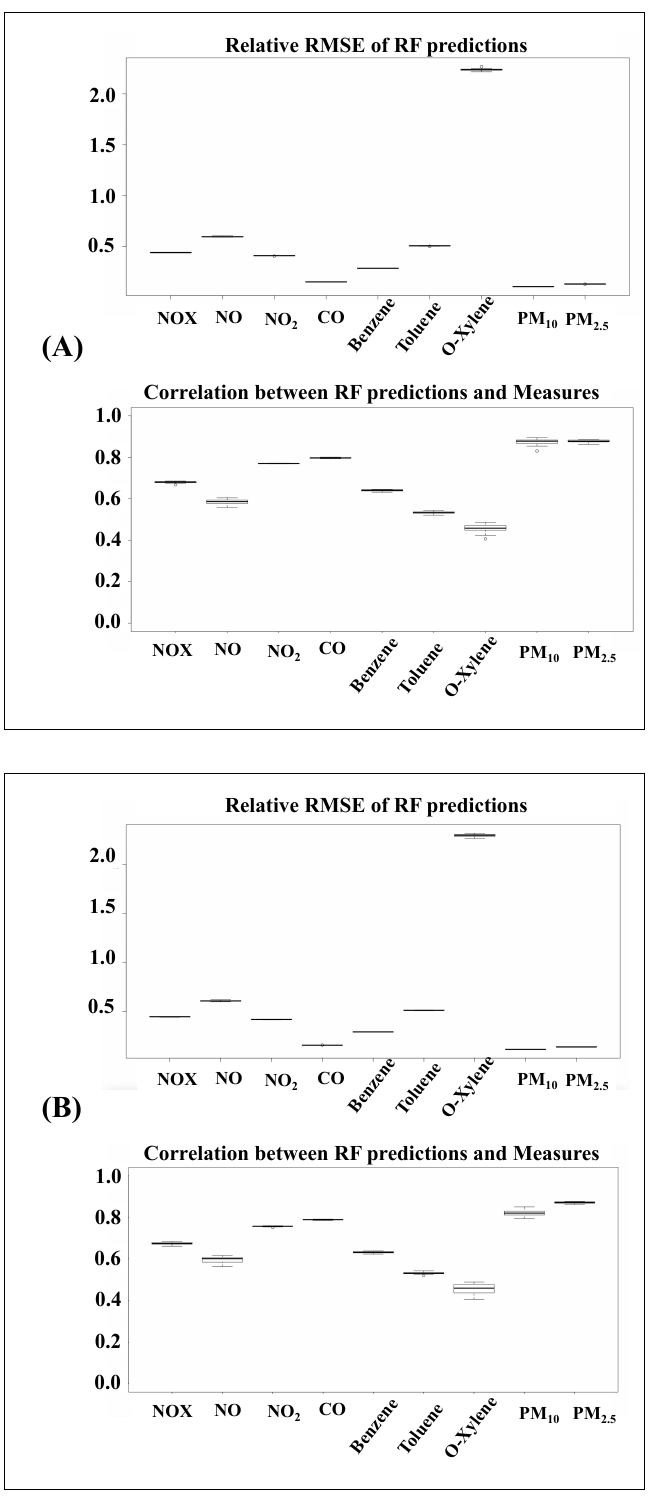
Figure 5. Distributions of the relative RMSE (top) and Pearson’s correlation coefficient (bottom) for each RF model using the WRF prediction for the first day (+24) on the lower resolution domain d01 ( A ) and on the higher resolution domain d02 ( B